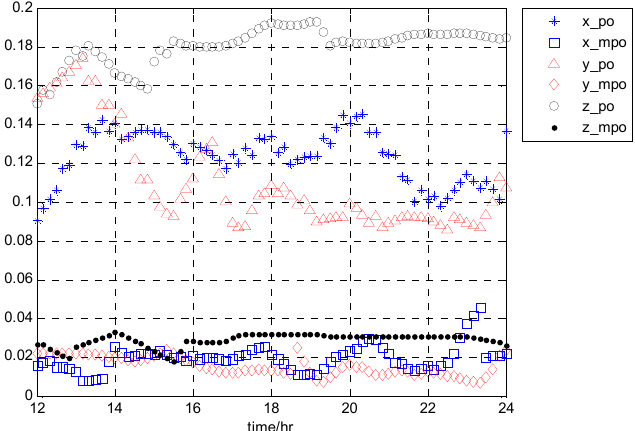
Figure 4. The variation in CDF difference with time (2017day121 UT12:00:00~24:00:00) for the two paired overbound methods, taking the result from PRN1 as an example.